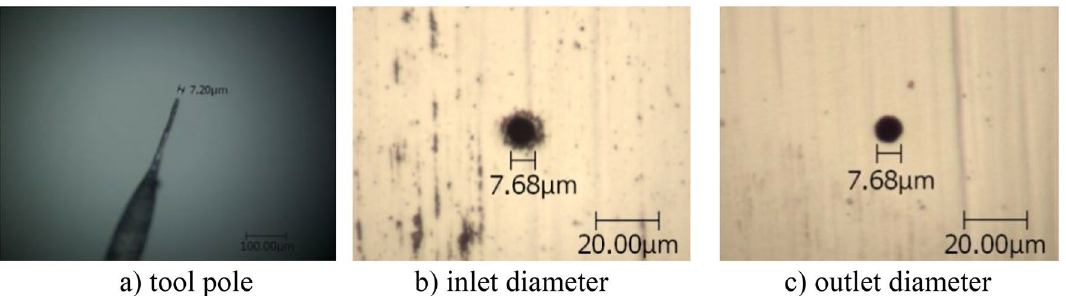
Figure 3. Micro holes produced at k 1 = 0.64 and k 2 =